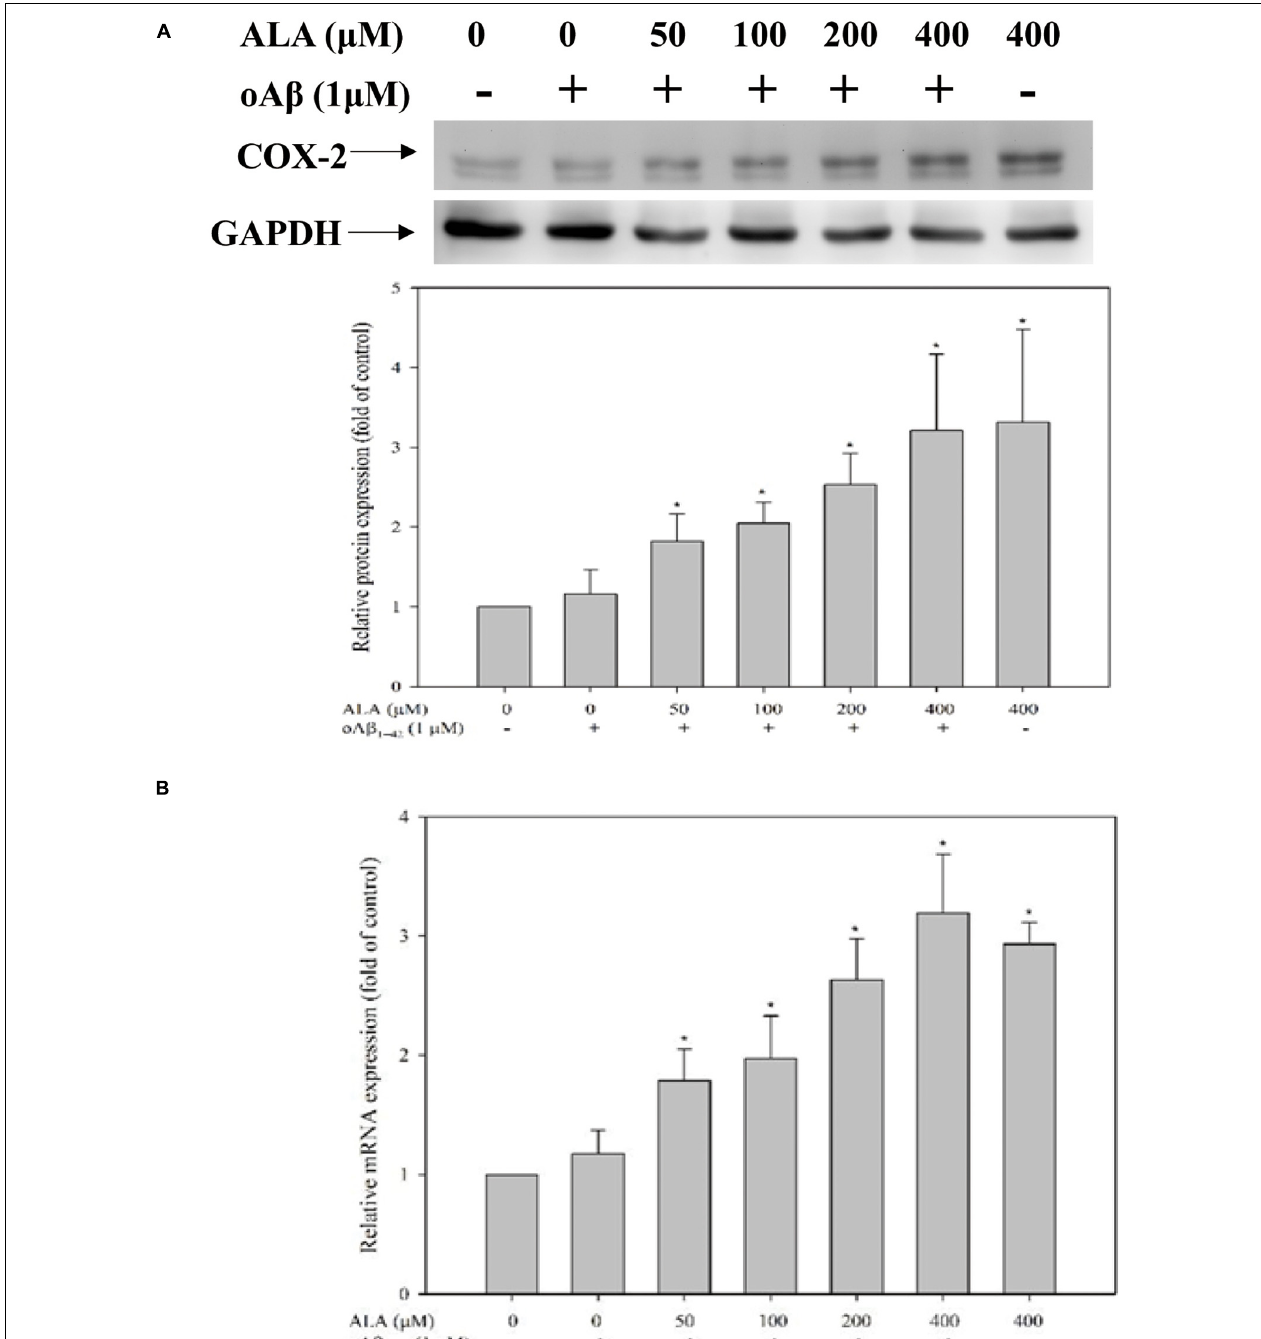
FIGURE 9 | Alpha-lipoic acid elevated cyclooxygenase-2 (COX-2) expression in BV-2 mouse microglial cells. BV-2 cells were pretreated with or without different concentrations of ALA for 30 min, followed by vehicle or oA β 1 − 42 treatment for 24 h. (A) The relative COX-2 protein expression was detected using western blotting. (B) The relative mRNA expression of COX-2 was determined using real-time PCR. * p < 0.05 vs. the vehicle control